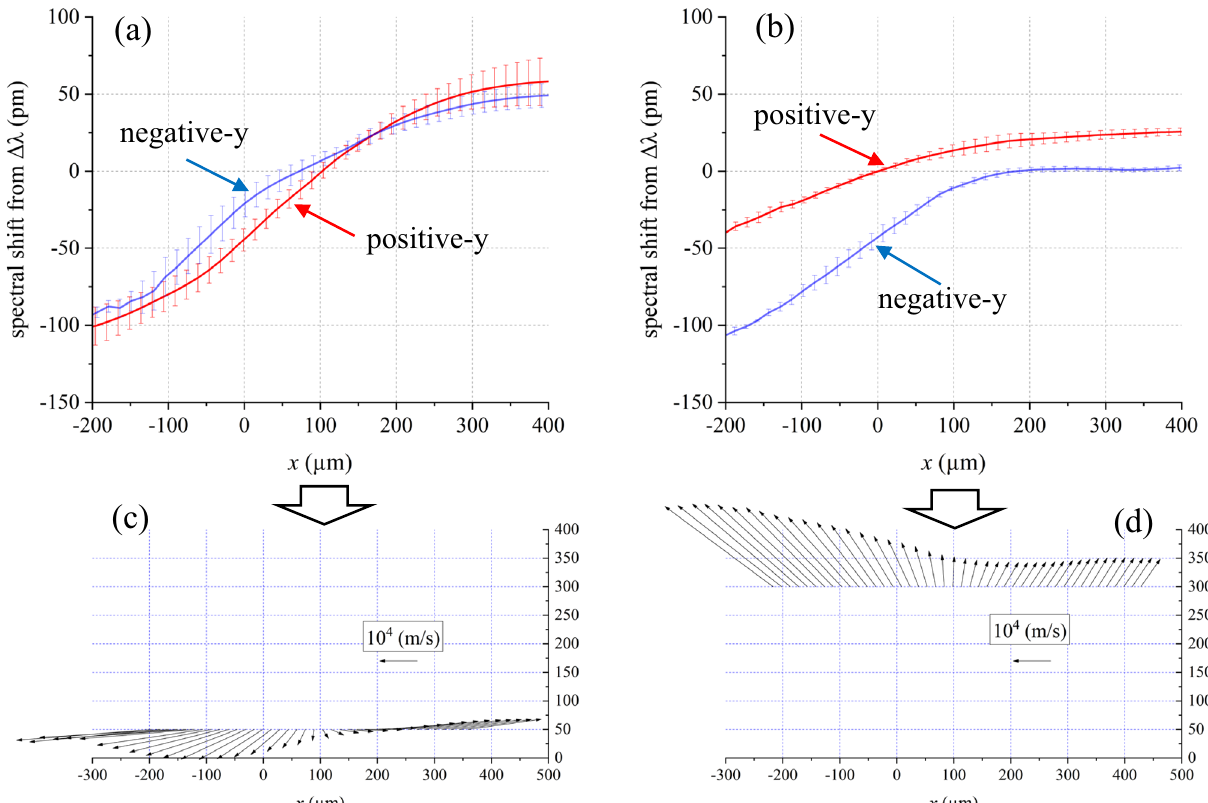
Figure 11. One-dimensional (cid:31) (cid:31) D + and (cid:31) (cid:31) D − profiles measured at ( a ) y = ± 50 μm (the 2.0 µs-plasma, t = 10 ns) and ( b ) y = ± 300 μm (the 1.3 µs-plasma, t = 10 ns). ( c ), ( d ): one-dimensional v flow profiles calculated from (cid:31) (cid:31) D + and (cid:31) (cid:31) D − profiles in ( a ) and ( b ),